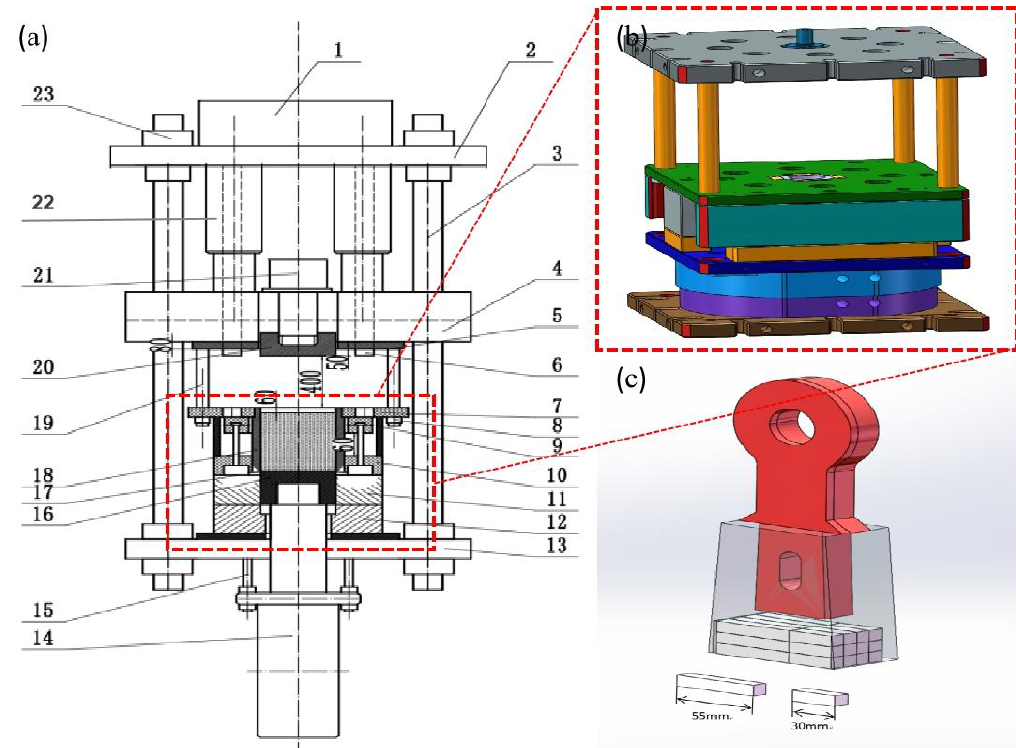
Figure 1. ( a ) Schematic of composite hammer squeeze casting; 1 — Hydraulic system; 2 — Upper beam; 3 — Column; 4 — Slider; 5 — Bar mounting plate; 6 — Push rod; 7 — Upper die pressing plate; 8 — Lock nut; 9 — Upper die sleeve; 10 — Upper die; 11 — Lower die; 12 — Lower die leg; 13 — Workbench; 14 — Lower head support cylinder; 15 — Lower cylinder hanger; 16 — Lower head; 17 — Workpiece mold cavity; 18 — Barrel; 19 — Pull rod; 20 — Upper ram; 21 — Squeeze cylinder; 22 — Clamping cylin- der; 23 — Lock nut; ( b ) Mould structure diagram; ( c ) Location and dimensions of the mechanical specimens. Table 3. Main technical parameters of hydraulic press.